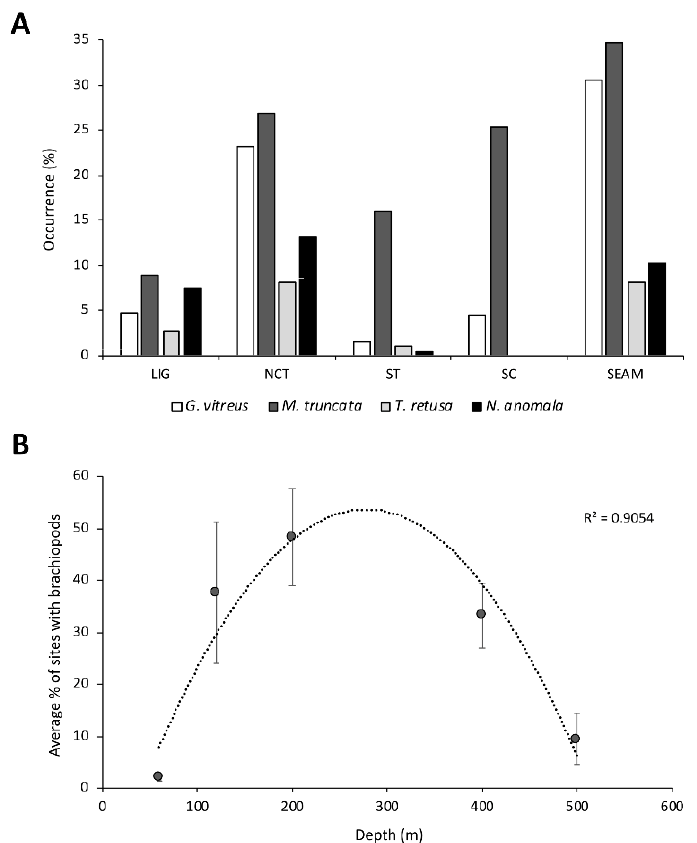
Figure 4. Geographic and bathymetric distribution of the target species. ( A ) Percentage of occurrence of the four brachiopod species in the investigated macro-areas. LIG, Ligurian Sea; NCT, North-central Tyrrhenian Sea; ST, southern Tyrrhenian Sea; SC, Sicily Channel; SEAM, seamounts; ( B ) correlation between depth and percentage of sites with brachiopods, expressed as the average ( ± SE) of all the macro-areas per each considered depth range (with n, the number of macro-areas, varying between 3 and 5). With regard to the overall bathymetric distribution of the target species, the boxplots highlighted wide ranges for all brachiopods, which mainly occurred from the mesophotic zone to the upper bathyal (Figure 5). Brachiopods were observed between 50 m and 659 m, with the shallowest record located in Capo Peloro (Messina Strait, southern Tyrrhenian Sea) and the deepest on Marsili Seamount (South Tyrrhenian Sea). The average percentage occurrence of all brachiopods species is significantly correlated with depth with a peak in the 150 – 250 m depth range (Figure 4B, Table 2).